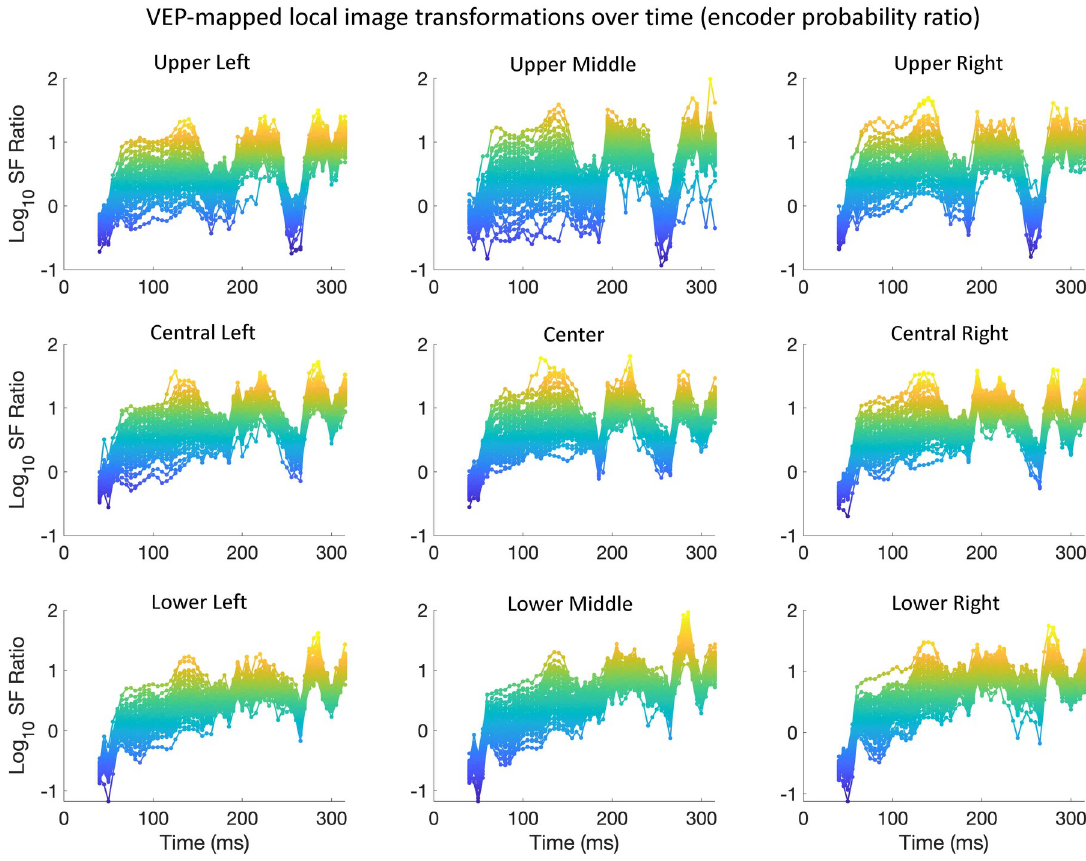
Fig 13. Participant averaged log 10 HSF-to-LSF probability ratio for each encoder tagged image over time, measured at nine different locations within stimulus space (see text for more details). The format of the plots is the same as in Fig 12A . transformation states. That plot illustrates the tendency of the lower image windows to result in more temporal variation, thereby suggesting more unique transformational states on a time point by time point basis. That observation was first verified with a one-way ANOVA includ- ing each image’s ratio and factor of time, F = 2.9, P = .005, with post-hoc t-tests showing (8,207) significant differences between all lower windows and the upper middle, upper right, and cen- tral right windows (P’s < .02). This suggests more dynamic representations in the lower por- tion of image space compared to the upper portion and may reflect a shift from a higher- dimensional representations to lower-dimensional representations across the image that may be relevant for perceptual decision making [54]. Further, such a differential shift in dimension- ality across the image may suggest a need to maintain different degrees of spatial dimensional- ity to allow for flexibility in perceptual decision making (though such an account is in need of further research). Nevertheless, what is striking about this local analysis is that the representa- tions contained within each region (upper, central, lower) is more similar than the representa- tions between each region. This further supports the finding that there are different neural coding operations at different image locations over time. Importantly, the differential transfor- mational states within different image regions suggest that the temporal coding of visual infor- mation is far more complex than a simple coarse-to-fine analysis and subsequent mapping to higher cortical representations [44–45].